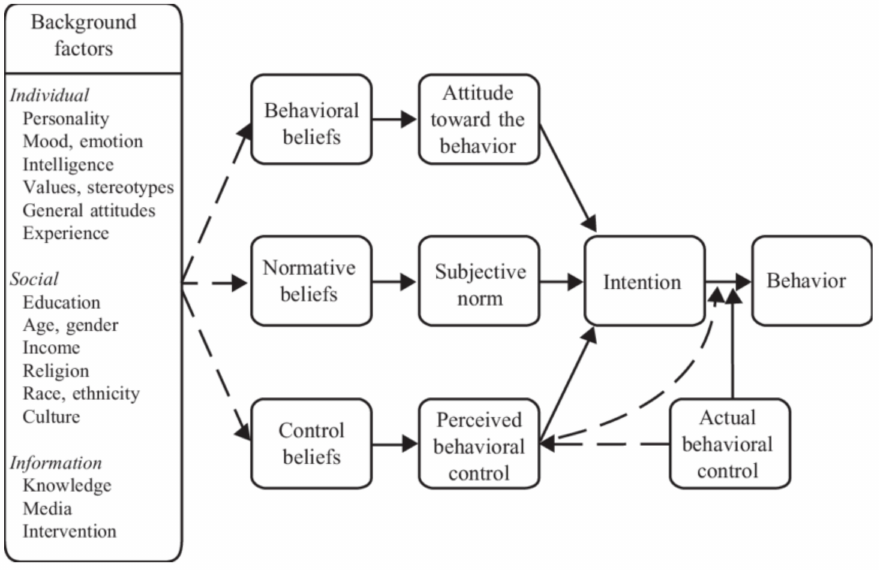
Figure 1. The theory of planned behavior framework (Fishbein and Ajzen,